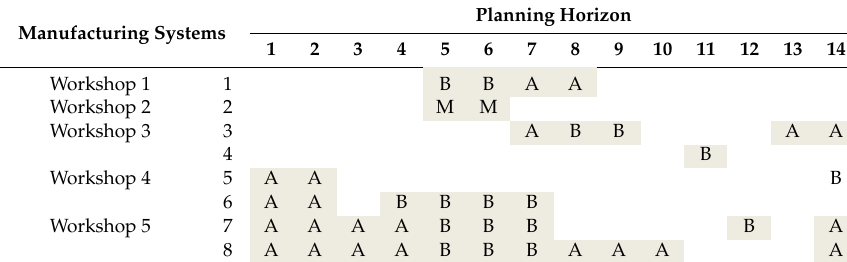
Table 4. Manufacturing systems’ initial unavailability.